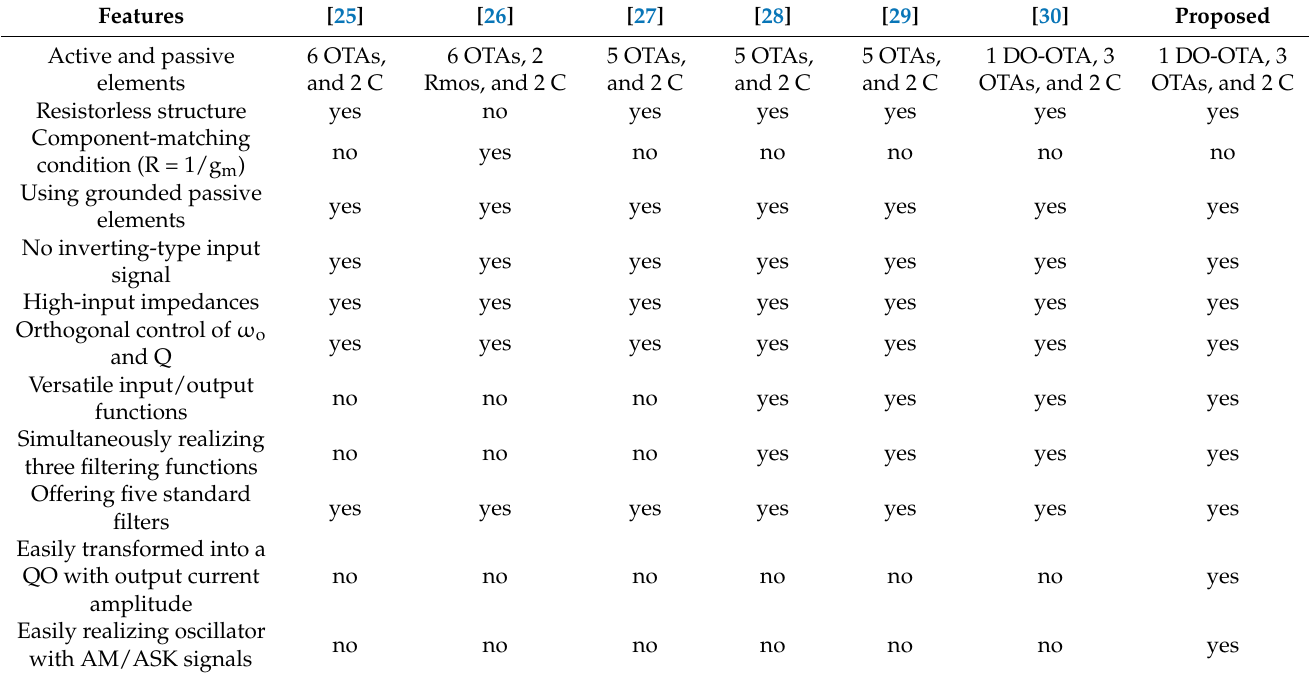
Table 1. Comparison of the proposed biquad and the biquads previously reported in the literature [25–30].